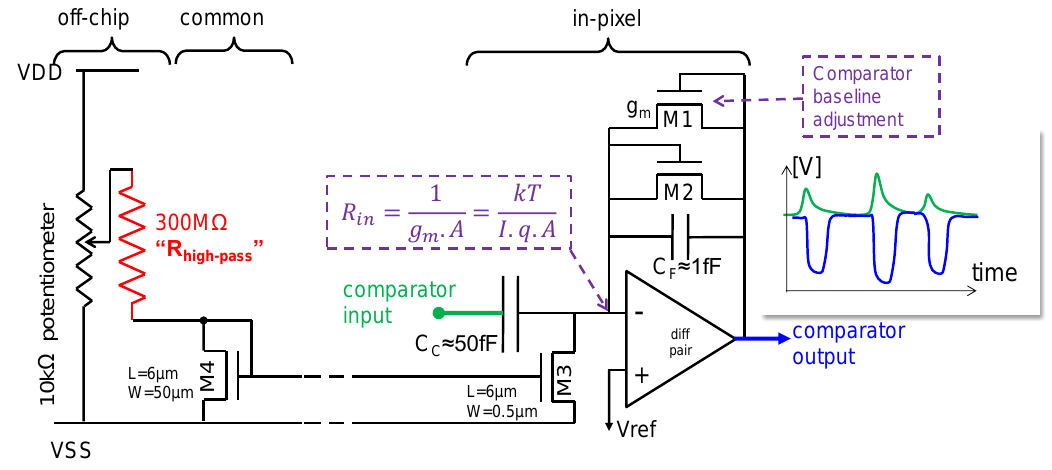
Figure 4. Comparator concept. Sensors 2016 , 16 ,, x